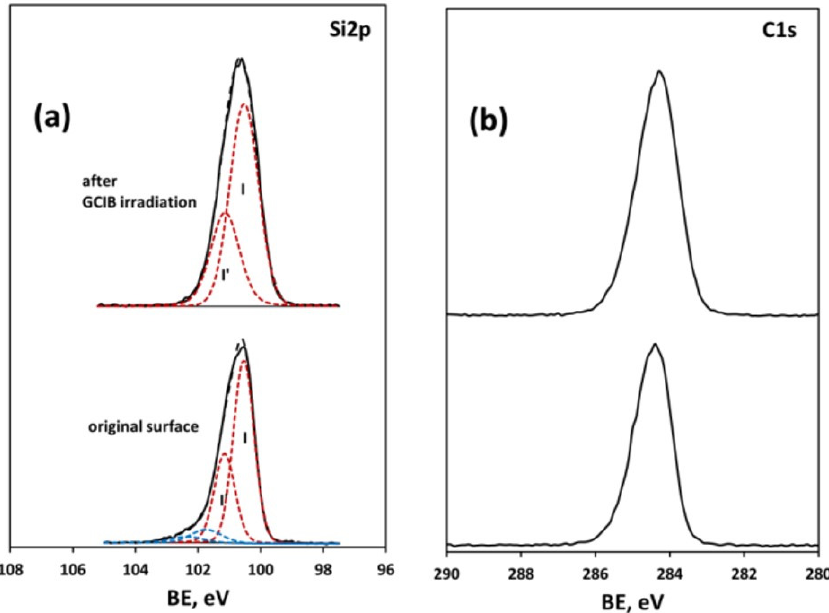
Figure 2. ( a ) Si 2p and ( b ) C 1s spectra of the raw PVTMS film for original surface (lower spectra) and after 10 keV Ar 2500+ irradiation for 60 min (upper spectra). Experimental curves—black solid lines; composite curves–black dashed lines; fitted doublet I-I’ at 100.4 eV assigned to Si[4C] environment—red dashed lines; fitted doublet II-II’ at 101.8 eV assigned to Si[3C O] environment–blue dashed lines.